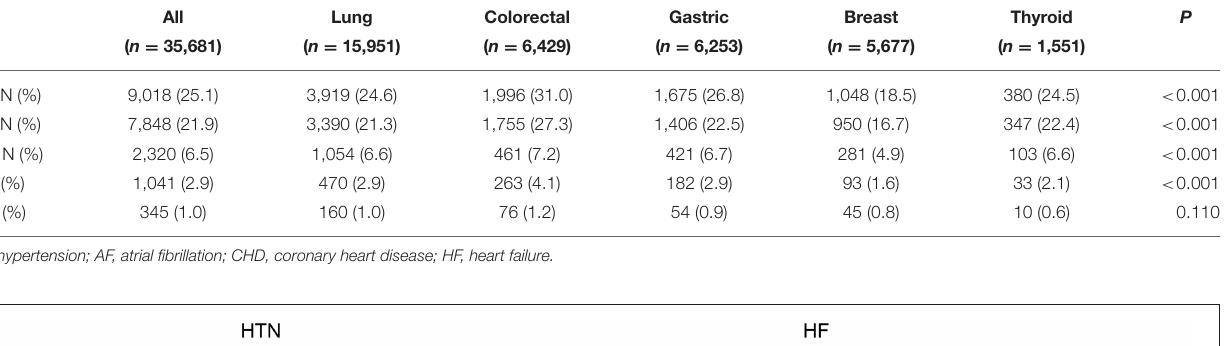
colorectal (OR = 3.049; 95% CI: 2.326–3.996, P < 0.001), and gastric (OR = 2.508; 95% CI: 1.927–3.264, P < 0.001)